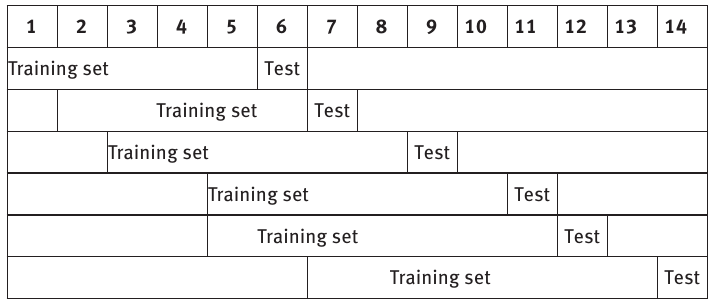
Table 2. Improved Sliding